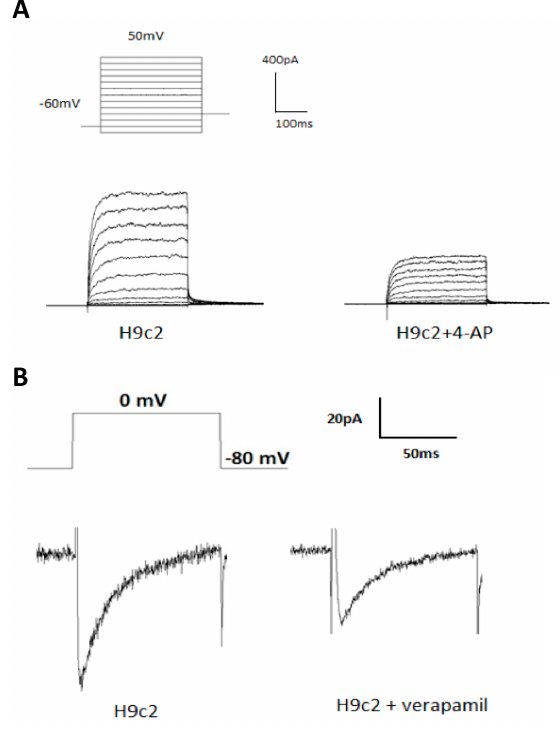
Figure 1. Delayed-rectifier potassium current (I K ) and L-type calcium channel current (I Ca,L ) in H9c2 cells. ( A ) Representative recordings of I K elicited by 300 ms of depolarizing step pulses from − 70 to 50 mV at a holding potential of − 60 mV in H9c2 cells. The I K was significantly suppressed by 4-aminopyridine (4-AP) (5 mM). ( B ) Representative recordings of the I Ca,L evoked by applying a pulse of 0 mV for 300 ms at a holding potential of − 80 mV in H9c2 cells. The I Ca,L was suppressed significantly by verapamil (1 µM).